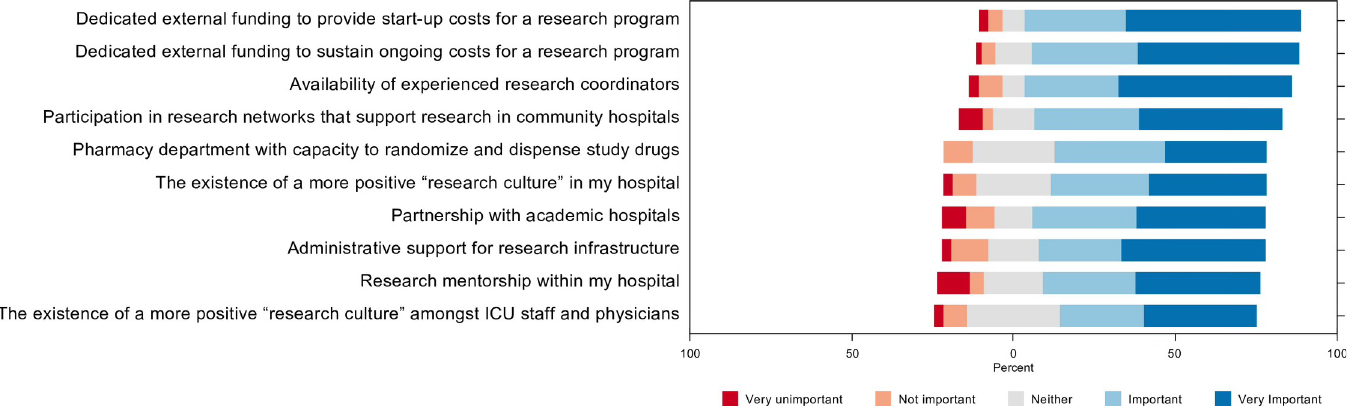
Fig 6. Facilitators of community ICU research